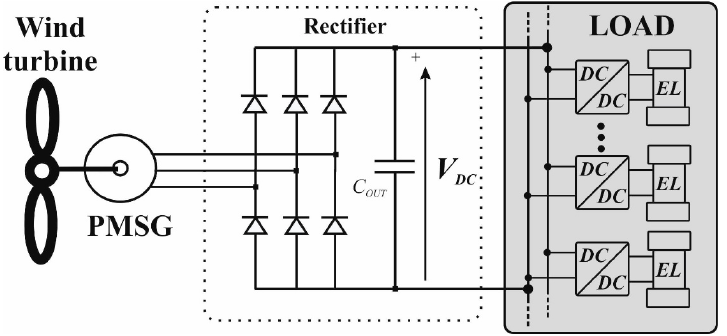
Figure 1. Representation of the turbine connected to the permanent magnet synchronous generator (PMSG) and the three-phase rectifier. EL, electrolyzer.